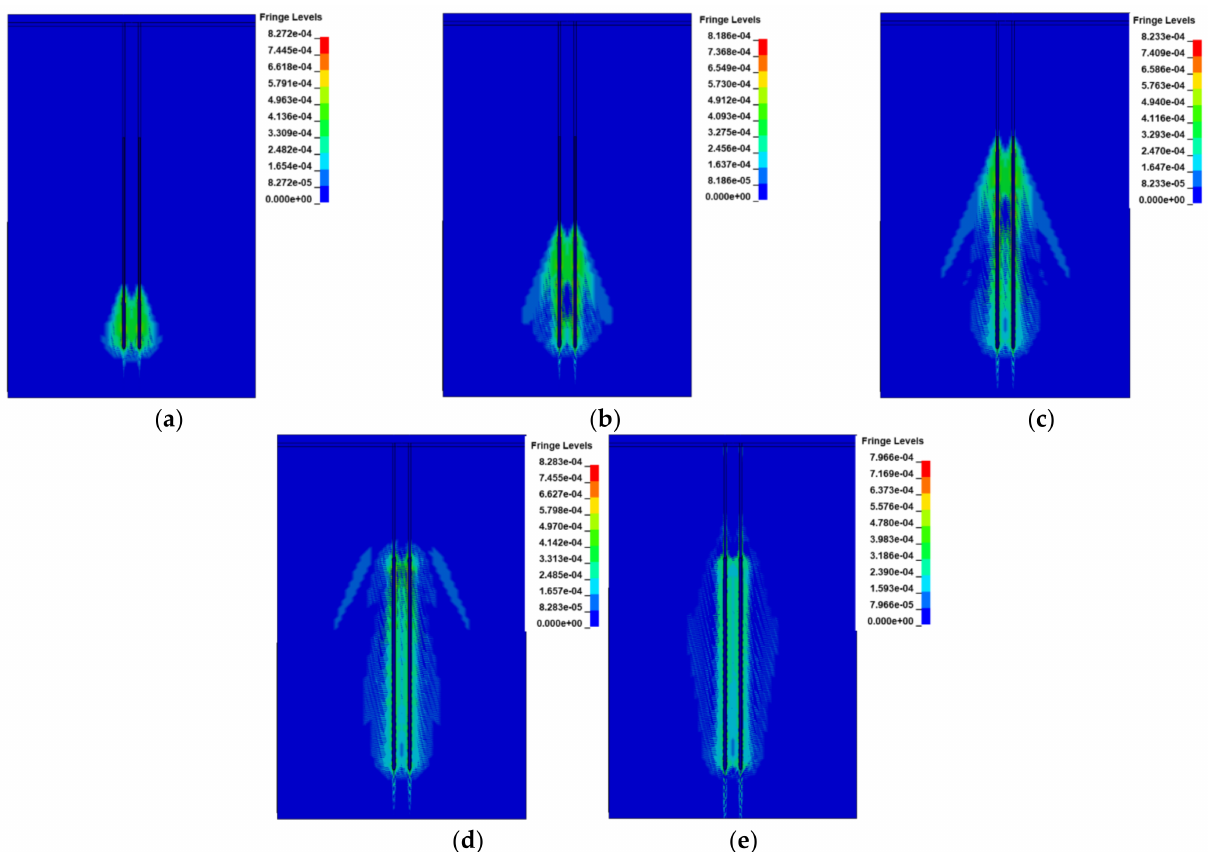
Figure 13. A 90 mm aperture 630 mm hole spacing stress wave propagation nephogram. ( a ) 0.5